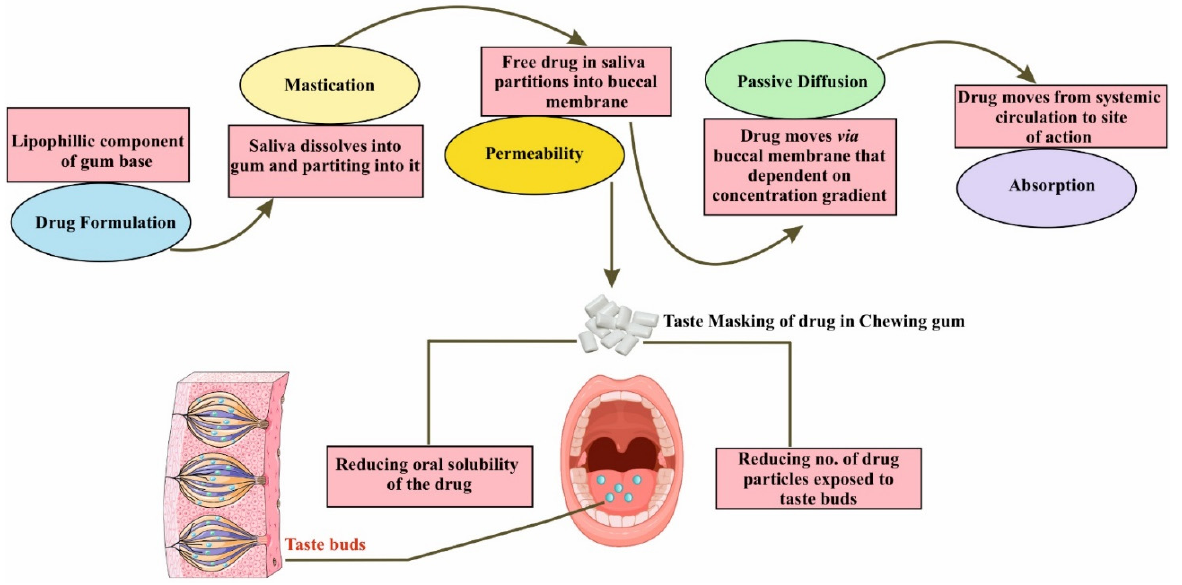
Figure 1. Mechanism of drug release and taste masking in chewing gums.